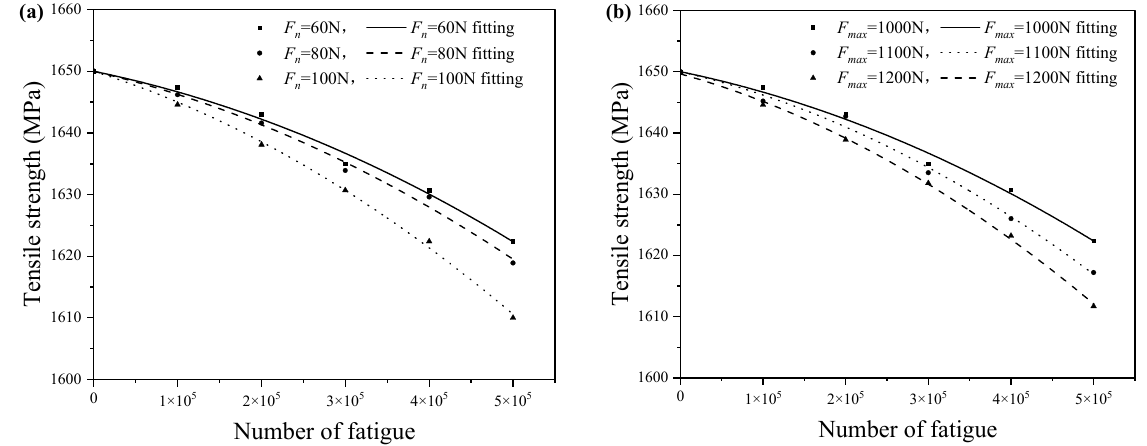
Figure 10. Strength degradation curves of worn wire (pair: groove) under different contact loads ( a ) and different fatigue loads ( b ). Table 6. Fitting equation of worn wire (pair: groove) strength degradation. Parameters